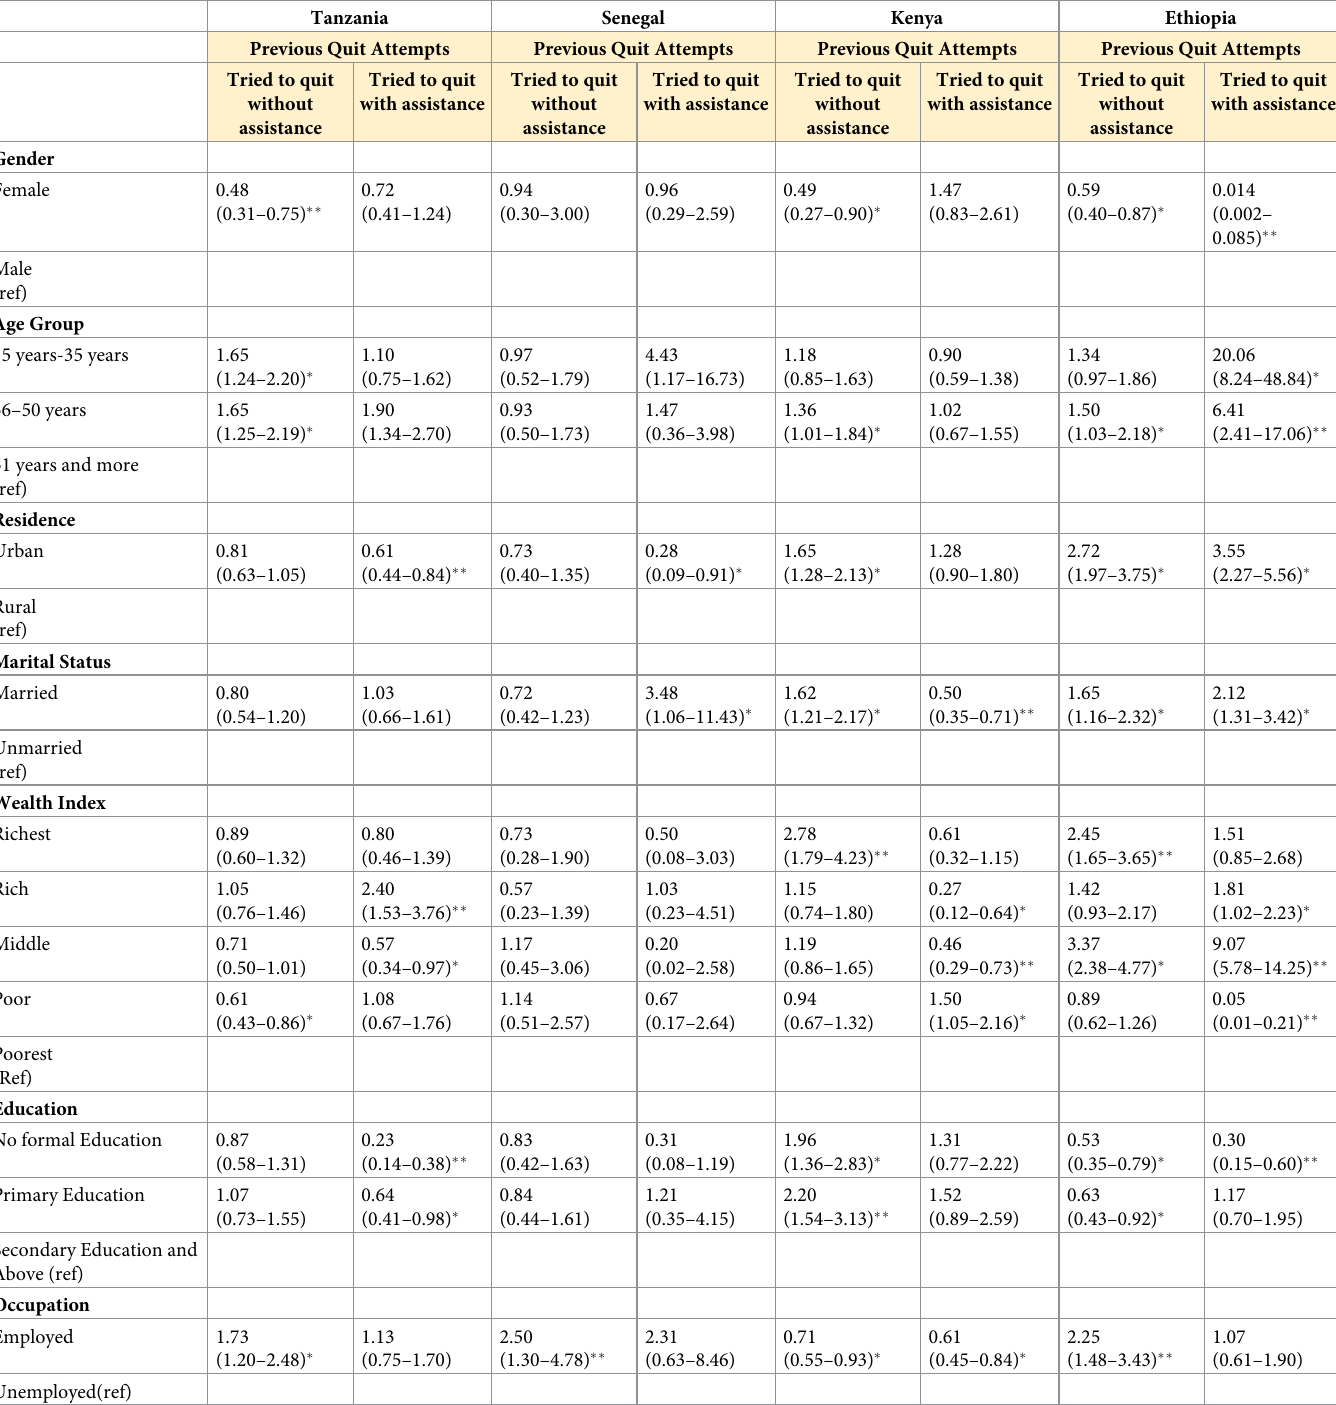
Table 4. Socio-economic factors associated with previous quit attempts across the four African countries.